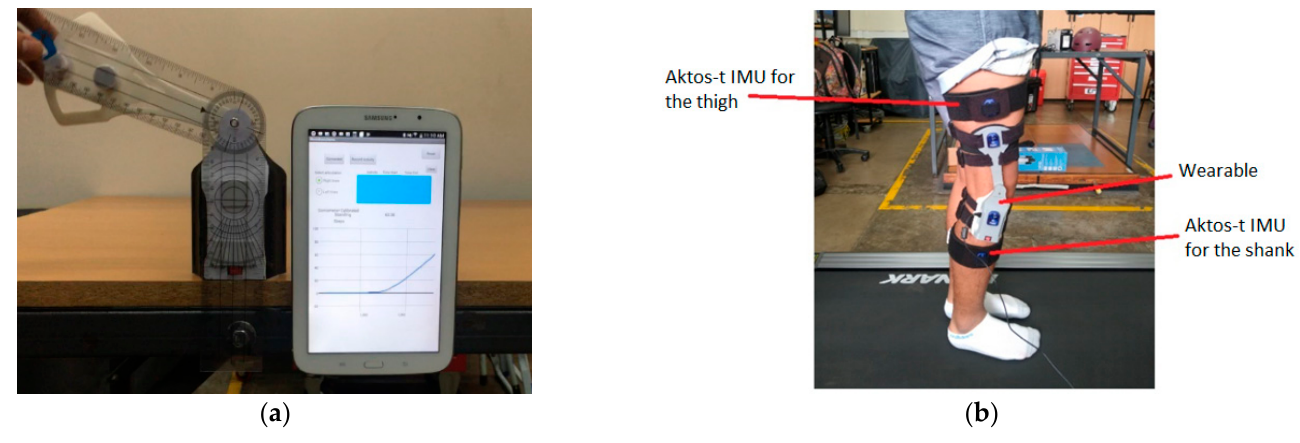
Figure 6. ( a ) Set up for the comparison of the wearable and the commercial goniometer; ( b ) set up for testing of the AROM. The wearable and the Aktos-t are worn by the subject.